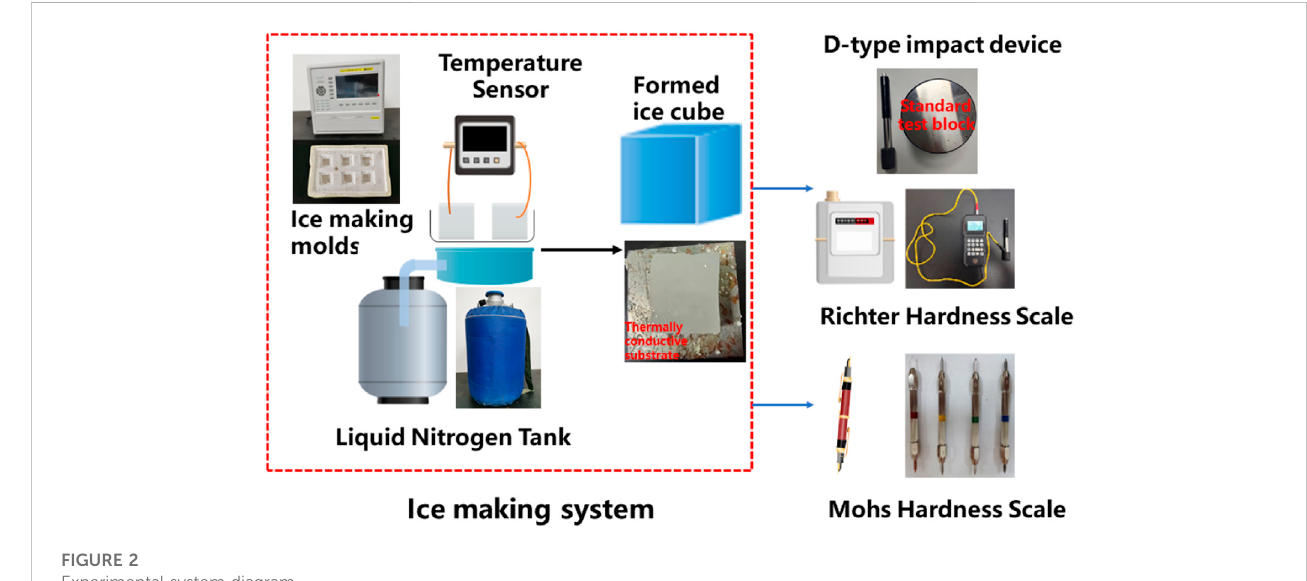
FIGURE 2 Experimental system diagram.